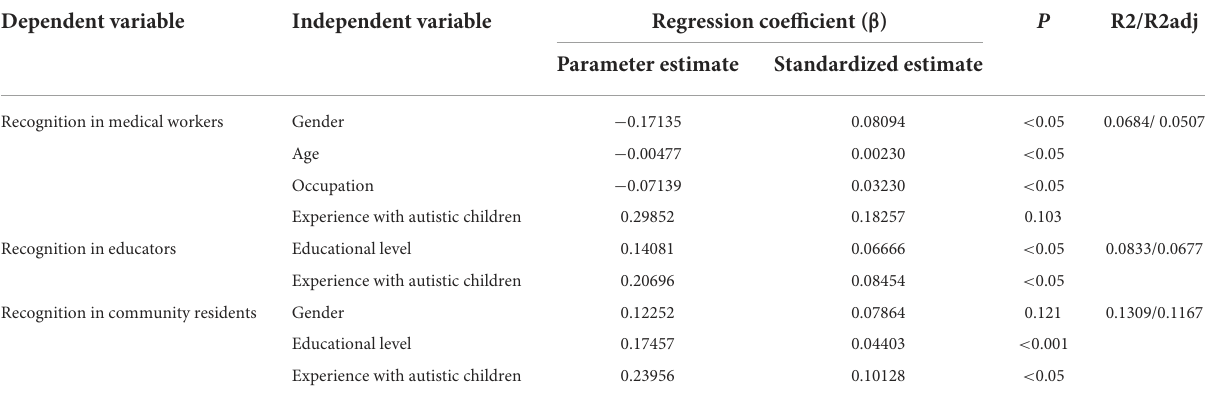
TABLE 7 Predictors that the three groups recognized autism